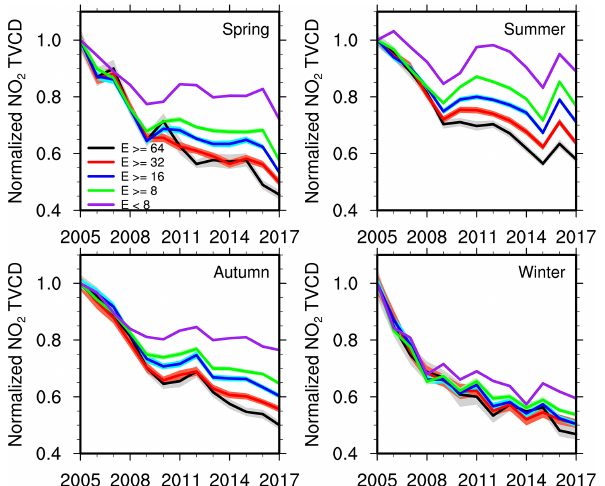
Figure 5. Relative annual variations in OMI-QA4ECV NO 2 TVCD for different anthropogenic NO x emission groups based on NEI2011 in each season from 2005 to 2017. “ E > = 64” denotes grid cells with anthropogenic NO x emis- sions over 64 × 10 10 molecules cm − 2 s − 1 . “ E > = 32” de- notes grid cells with anthropogenic NO x emissions equal to or larger than 32 × 10 10 moleculescm − 2 s − 1 but less than 64 × 10 10 moleculescm − 2 s − 1 . “ E > = 16” and “ E > = 8” have similar meanings as “ E > = 32”. “ E < 8” denotes grid cells with anthropogenic NO x emissions less than 8 × 10 10 moleculescm − 2 s − 1 . Shading in a lighter color is added to show the standard deviation of the results; when uncer- tainty is small due in part to a large number of data points, shading may not show